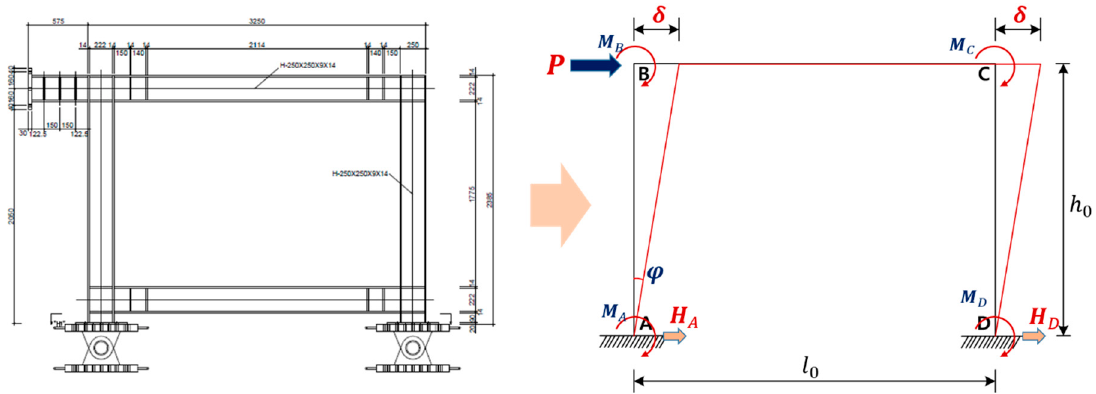
Figure 6. A simplified model of a steel frame specimen.